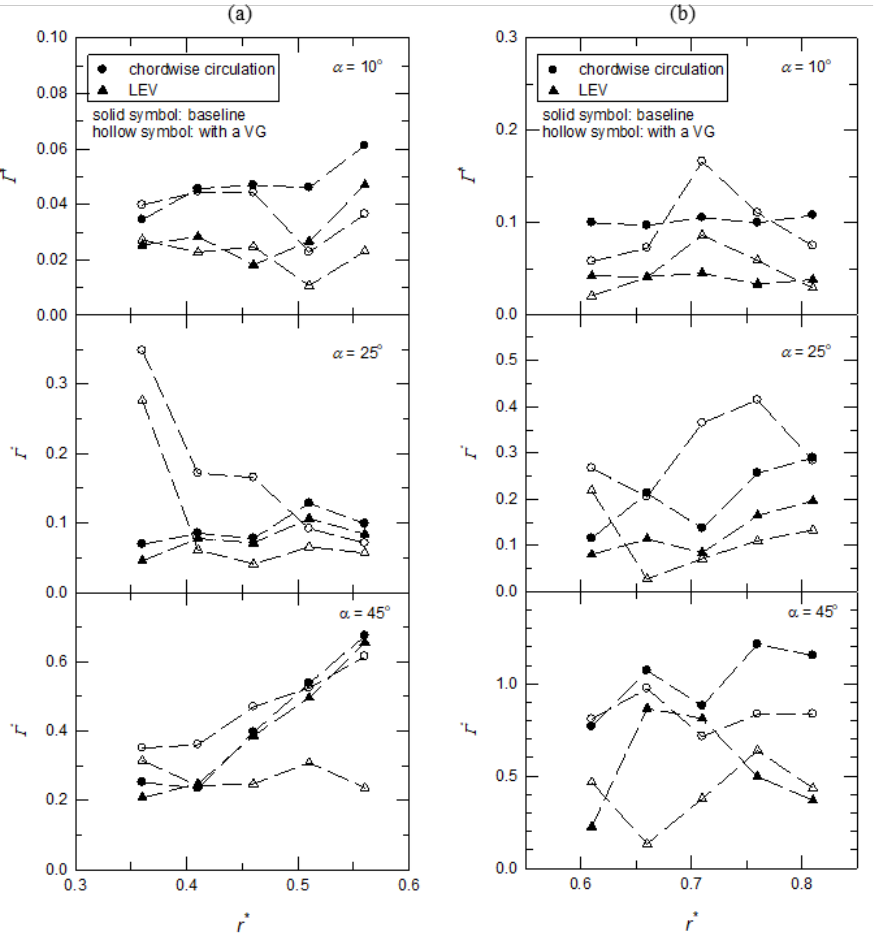
Figure 11. The normalized circulation ( Γ *) of the wing model with an alula-VG on different x-z planes at different angles of attack. ( a ) An alula-VG placed at L w * = 0.25; ( b ) an alula-VG placed at L w * = 0.50.